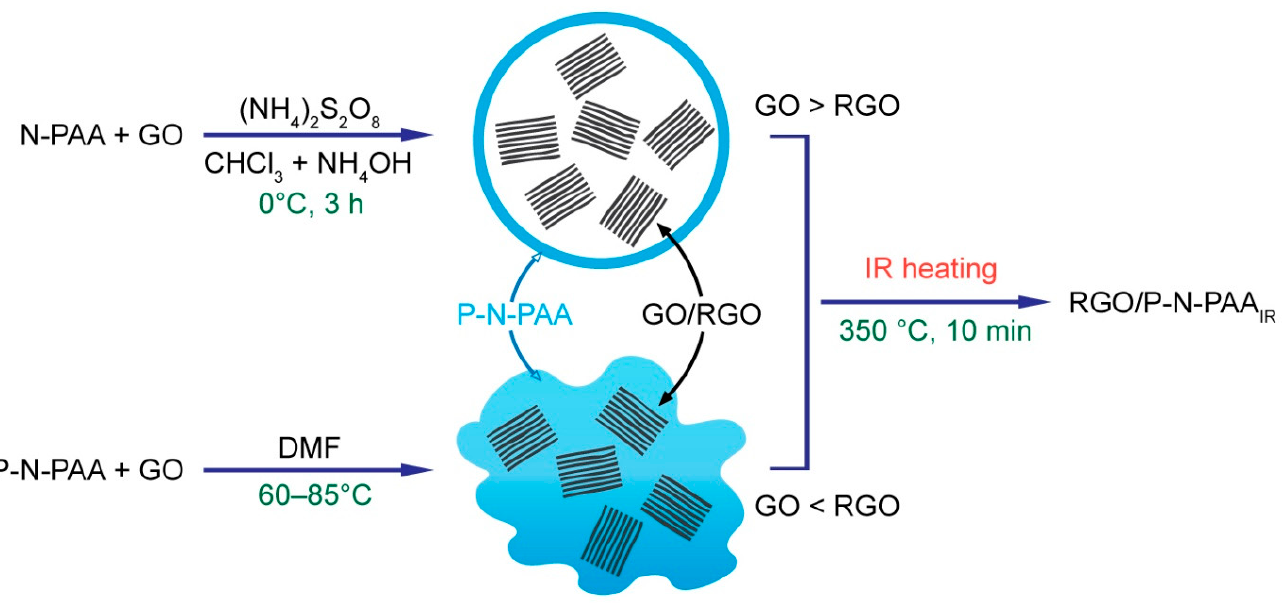
Figure 1. Scheme of the RGO/P-N-PAA materials synthesis.